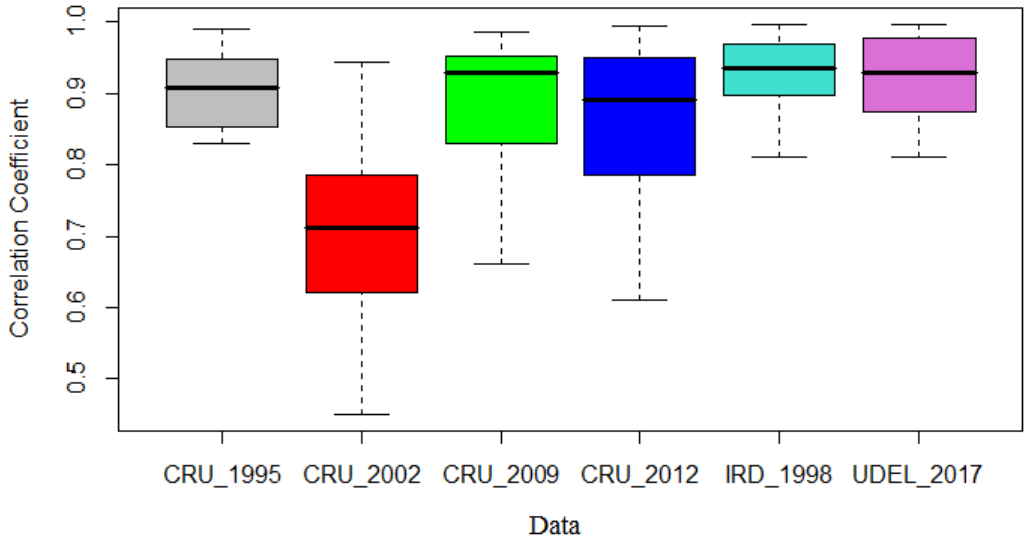
Figure 3. Correlation coefficient between the grids and the observations - The whisker boxes represent the statistical extend of the time series. The bottom whisker represents the minimum between the minimum of the time series and the median − 1.5∆Q (∆Q represents the interquartile length). The bottom of the box represents the first quartile (25%). The bold dash represents the median (50%). The top of the box represents the third quartile (75%). The upper whisker represents the minimum between the maximum of the time series and the median + 1.5∆Q.